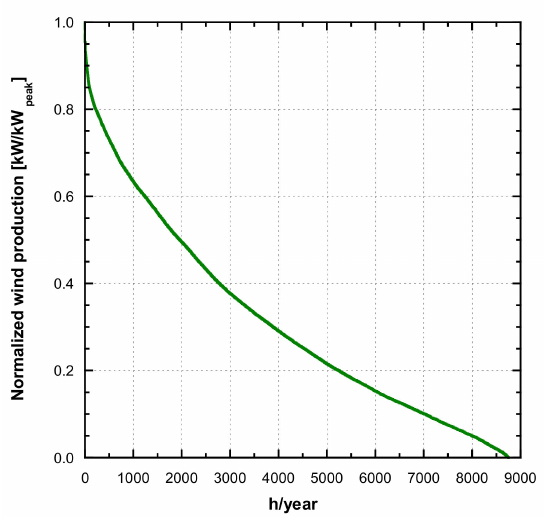
Figure 8. Normalized wind production profile